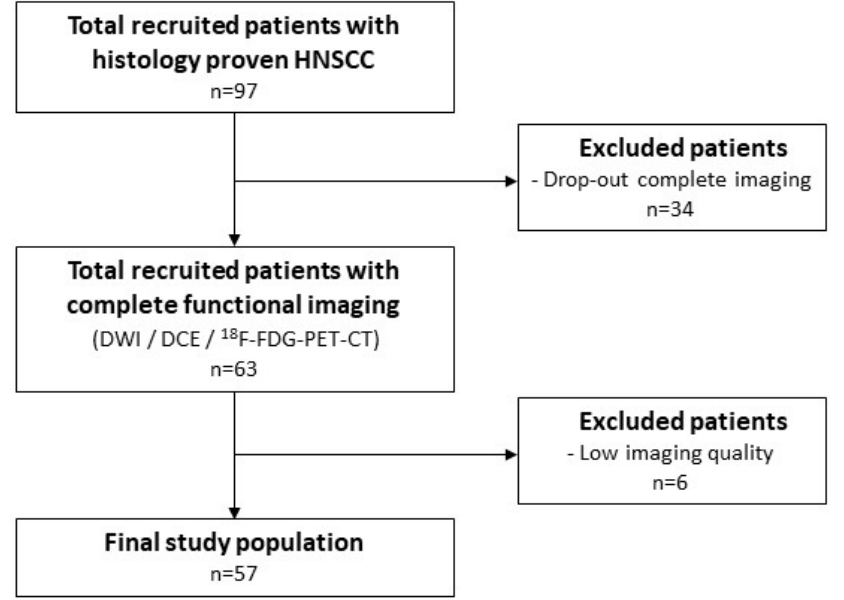
Figure 2. Flowchart of patient inclusion.